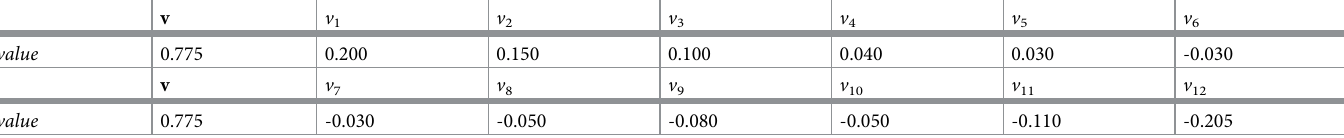
Table 2. Compensation amount of pixel moving speed in Y direction between different images in swinging